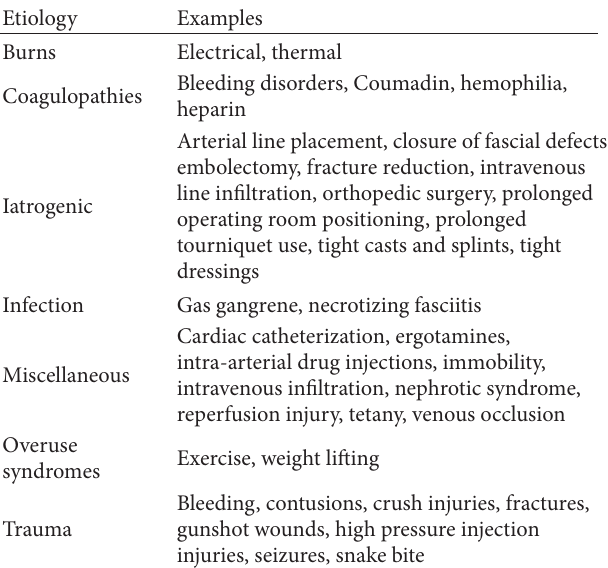
Table 2: The varied etiologies of a compartment syndrome [1, 3, 5–